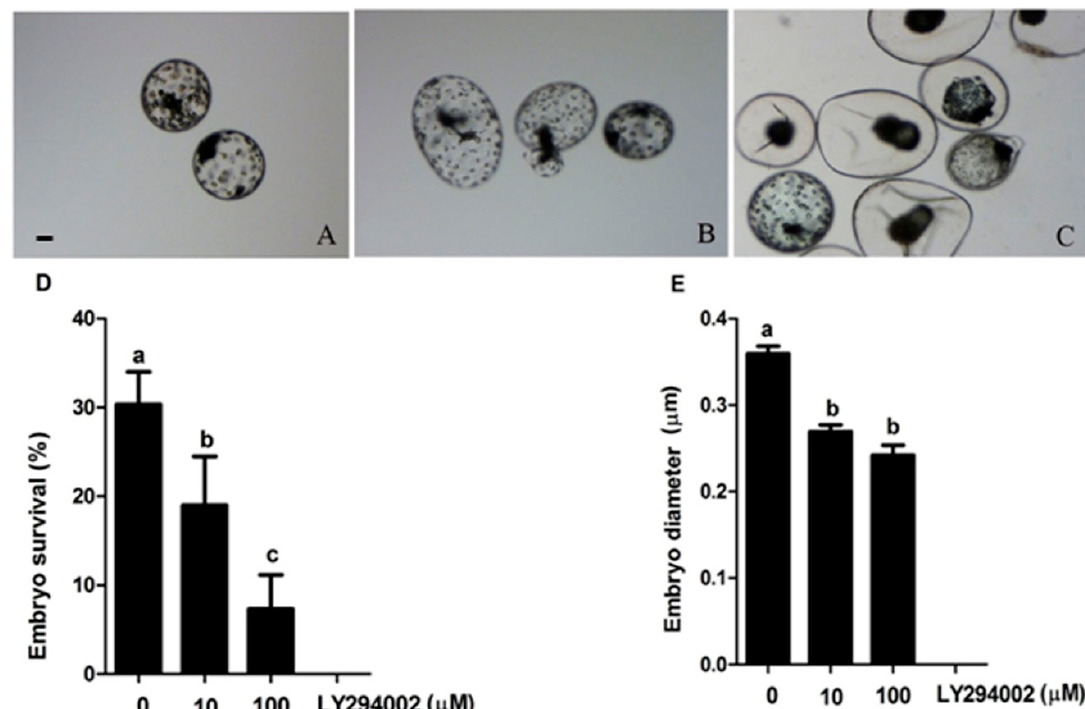
Figure 6. Mink embryos recovered in obligate diapause and cultured with di ff erent concentrations of the PI3K / AKT inhibitor (LY294002). The morphology of embryos was evaluated under a stereomicroscope. ( × 200) ( A ) Diapause embryos, ( B ) Expanded embryos indicative of reactivation, ( C ) Dead embryos, ( D ) Embryo survival after five days culture, ( E ) The mean diameter of the blastocysts after five days culture. Significant at p < 0.05. Data are mean ± SEM. Di ff erent small letters above columns indicate significant di ff erences by Student’s t -test.